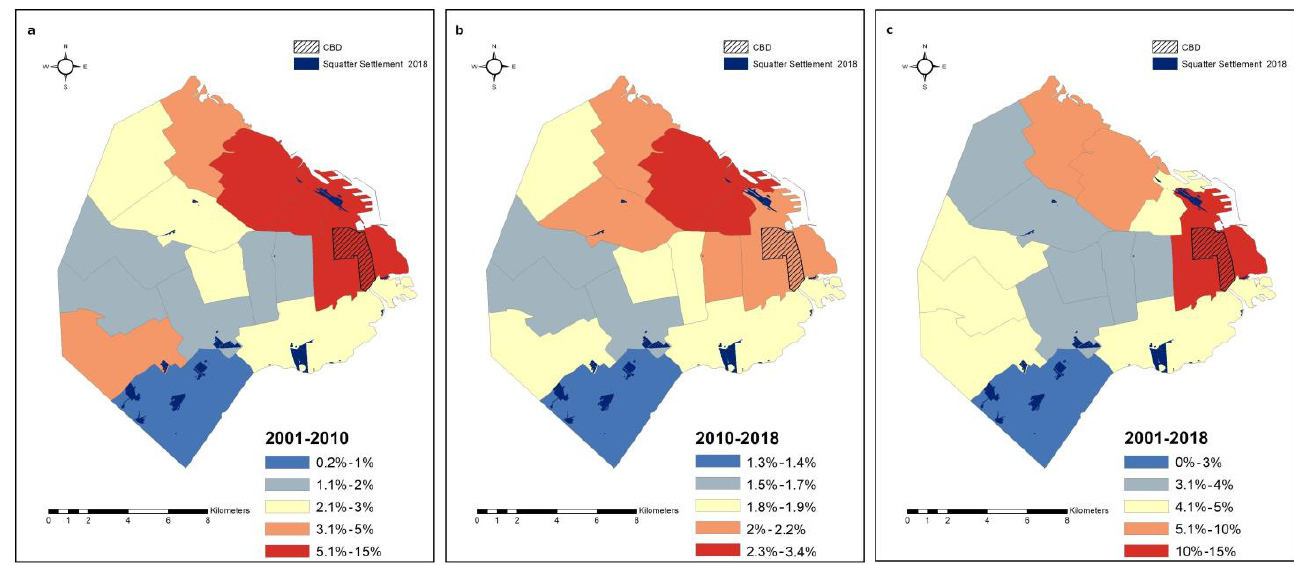
Figure 3. House prices controlled for housing structure ( a ) 2001, ( b ) 2010, and ( c ) 2018. Figure 4 shows changes in controlled average house prices by communes. This figure thus shows a particular positive polarization of the values, located near the CBD, and a negative one, situated in the city’s southern area. The communes in the south with multiple squatter settlements have the lowest increase in house values compared to the rest of the city.